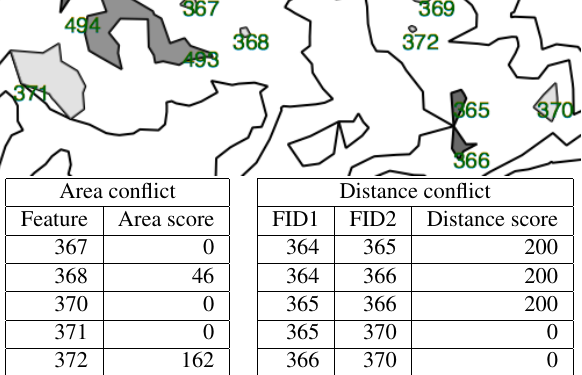
Figure 10: Examples of conflict evaluations. A score of 0 means that no conflict